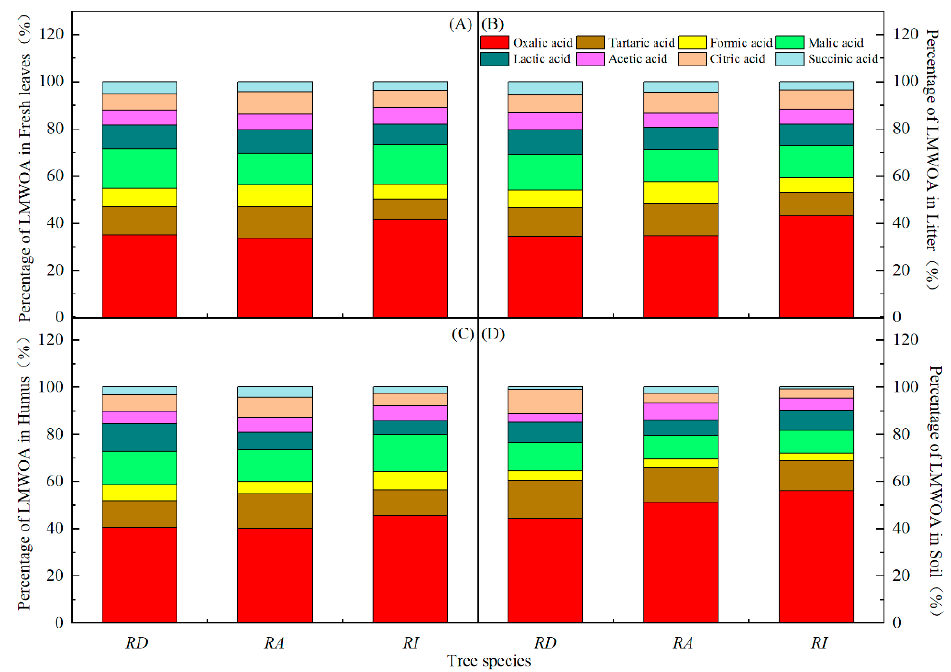
Figure 4. Composition and percentage of LMWOAs in the different rhododendron forests. Note: ( A – D ) in the figure represent the percentage of LMWOAs in the fresh leaves, litter, humus, and soil in different evergreen broadleaved rhododendron forests.